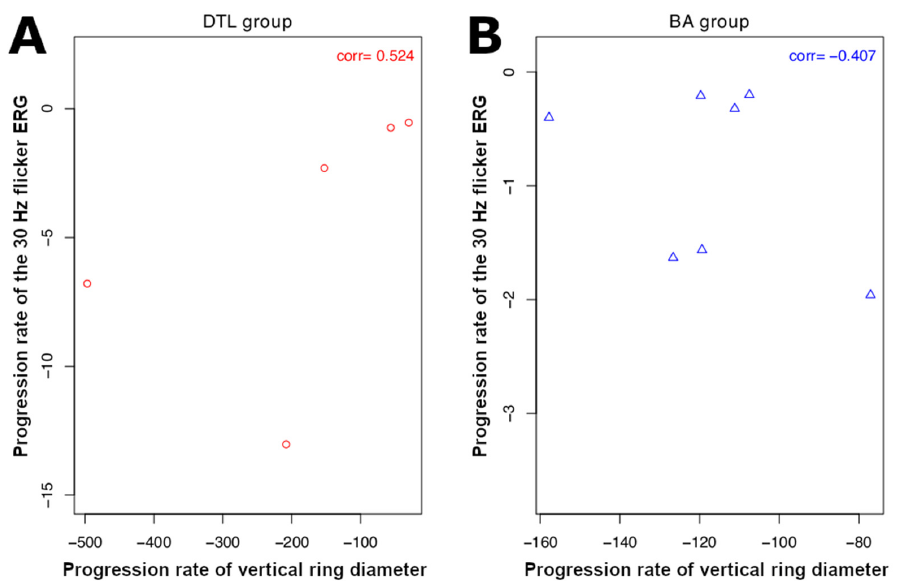
Figure 3. Scatter plots of the progression rate of 30 Hz flicker electroretinogram (ERG) amplitude versus that of vertical ring diameter: ( A ) progression rates of patients in DTL and ( B ) BA groups. Correlations between progression rates are not significant in either DTL or BA groups. Here ’corr’ at the top-right corner of each subplot denotes correlation coefficient.